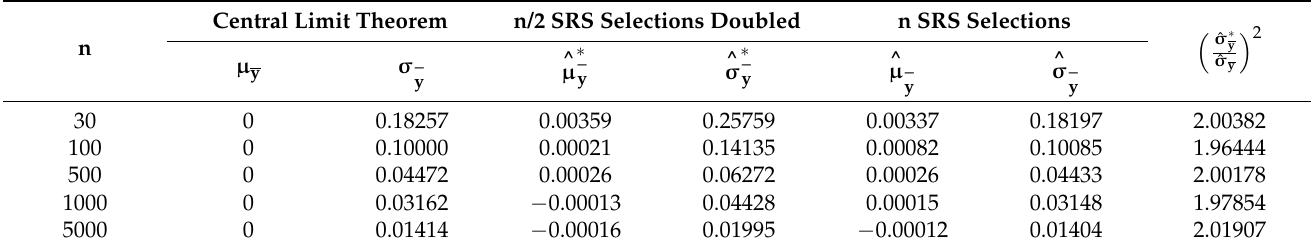
Table 1. A SRS and correlated data simulation experiment synopsis; 10,000